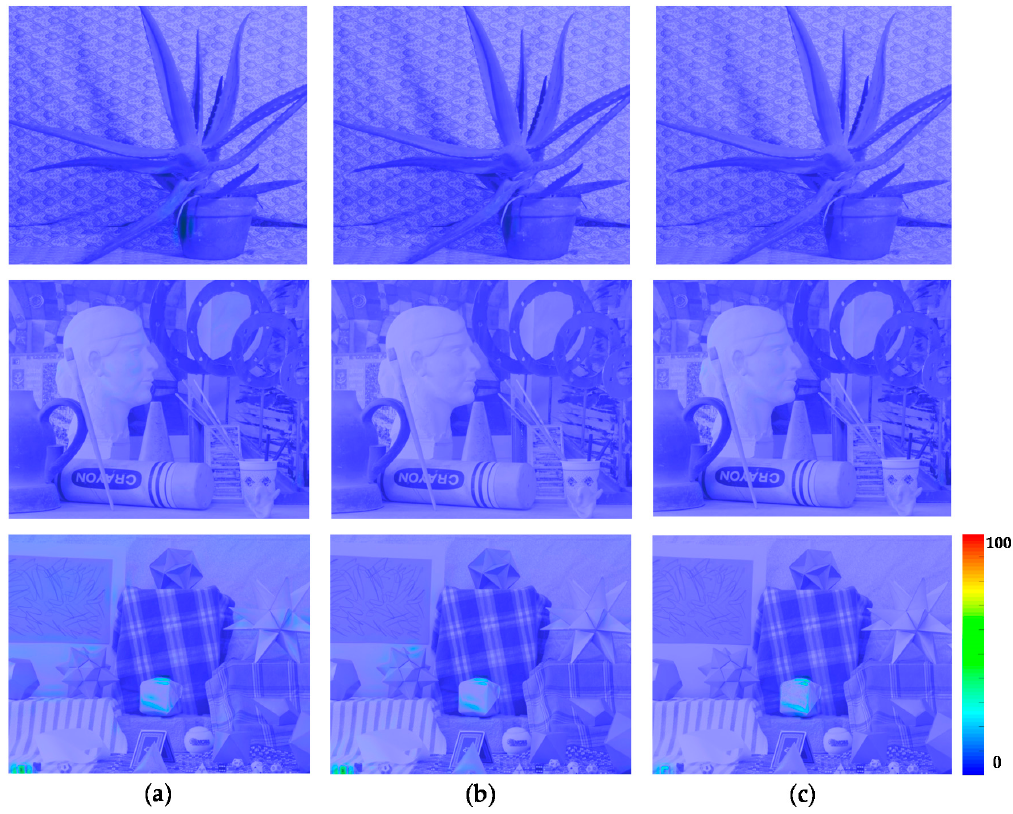
Figure 16. Resultant HDR visual difference predictor 2 (HDR-VDP2) maps for the Middlebury database with normal-long exposure: ( a ) Lin and coworkers’ method [14]; ( b ) Batz and coworkers’ method [16]; and ( c ) proposed method.